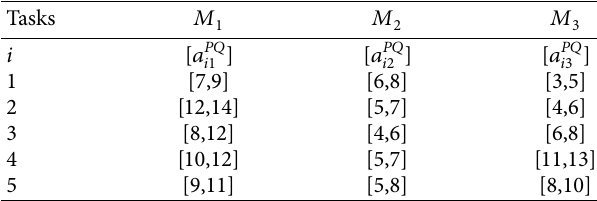
Table 6: PQFN processing times with interval format.